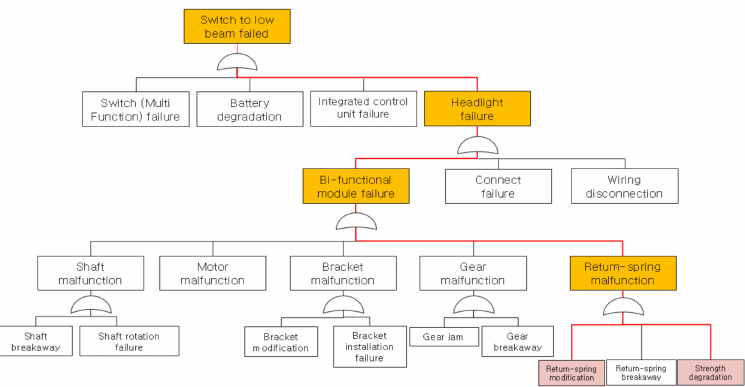
Figure 4. Fault tree analysis (FTA) of a bi-functional DC motor system in an automobile.